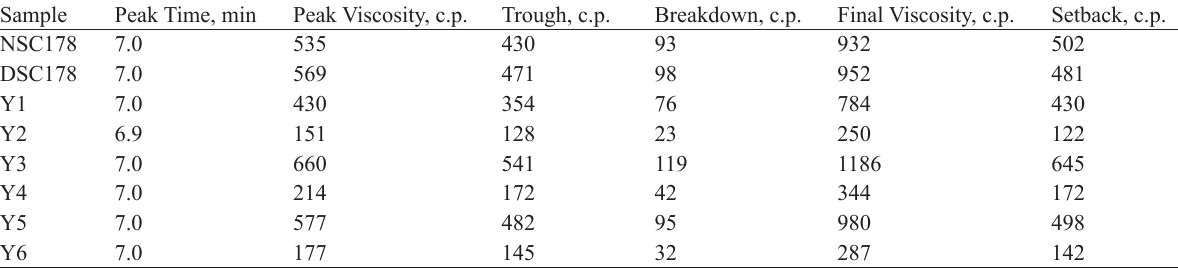
Table 2 Pasting properties of nixtamalized corn flour Sample Peak Time, min Peak Viscosity, c.p. Trough,